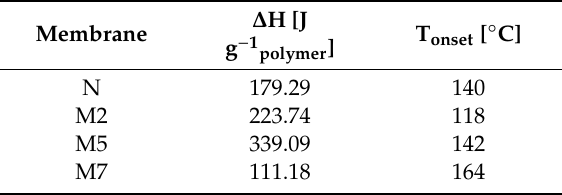
Table 2. Δ H and the T onset associated to the DSC thermal transition of the polymer ionic clusters in the membranes (see Figure 4).